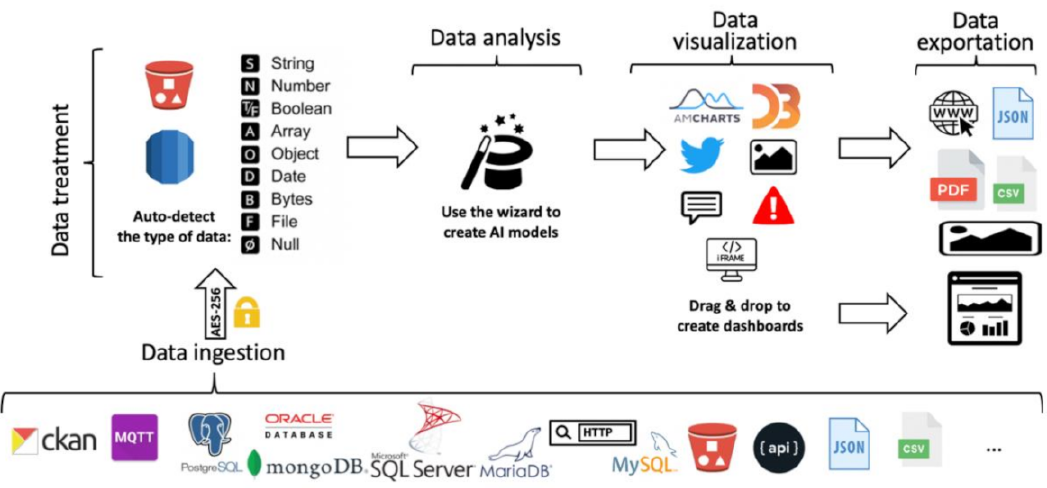
Figure 2. Flow and elements of data